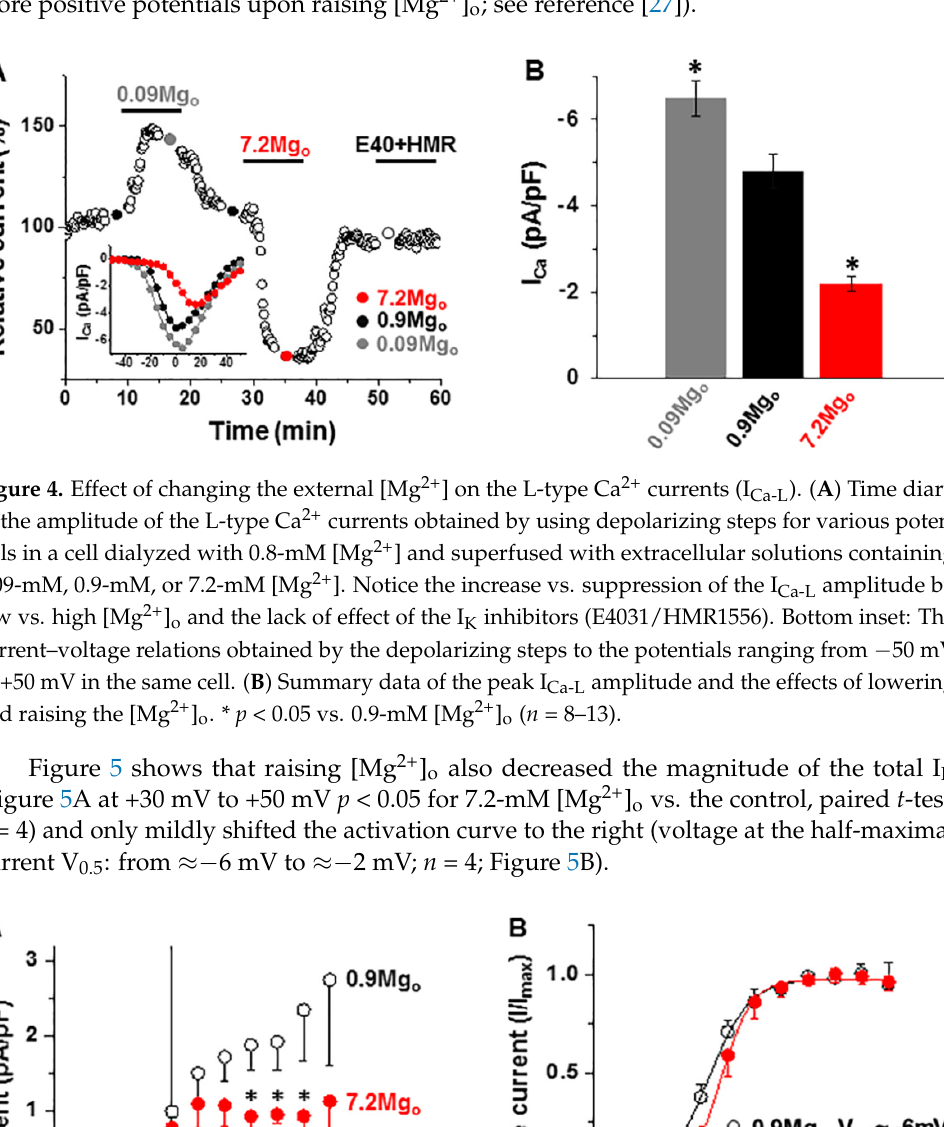
I Ca-L –voltage relationships (see Figure 4A, inset) indicate that the [Mg 2+ ] o changes shifted the activation curve of I Ca-L (to more negative potentials upon lowering the [Mg 2+ ] o and to more positive potentials upon raising [Mg 2+ ] o ; see reference [27]).